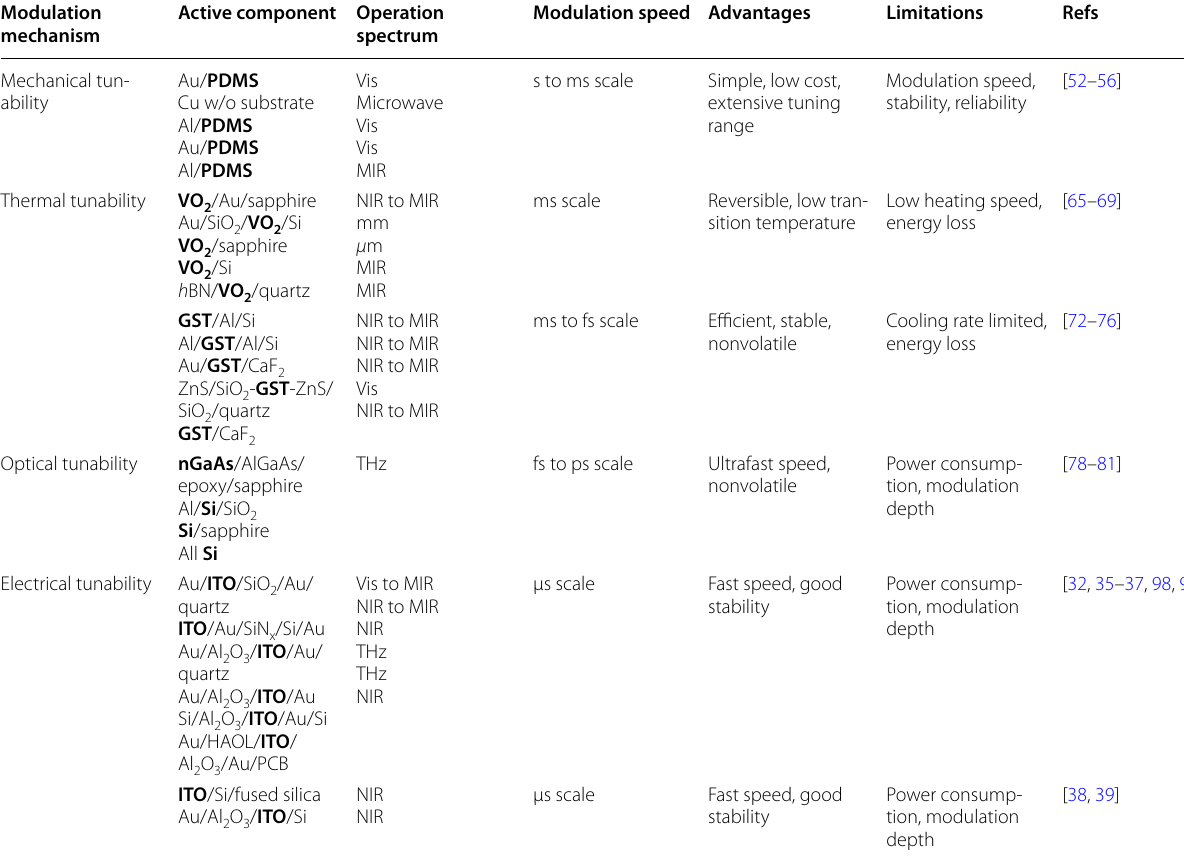
The significance of bold indicates the corresponding tunable components in metasurfaces for different types of modulation mechanisms